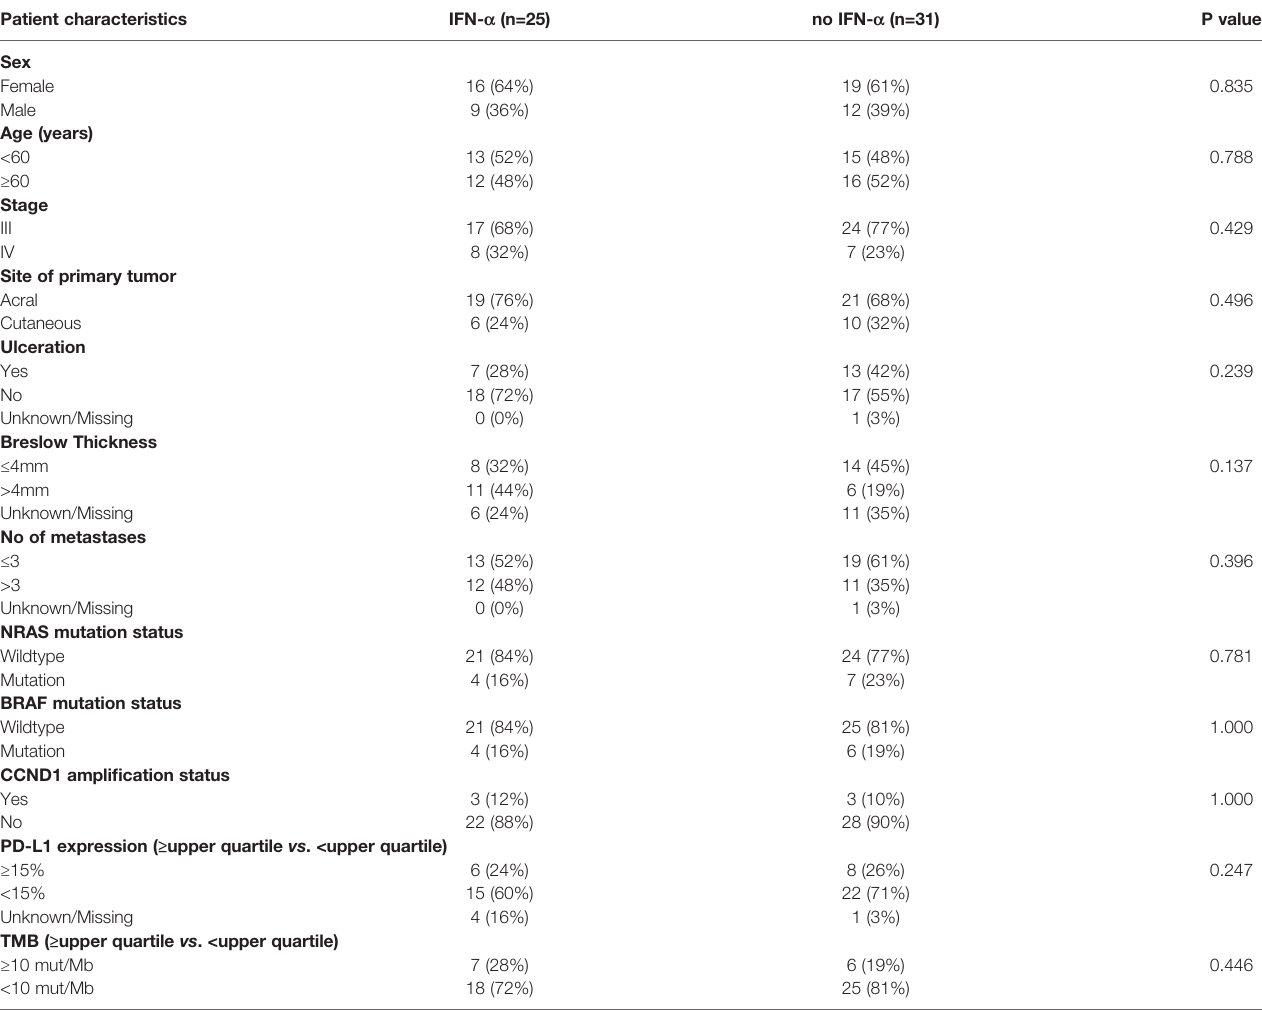
TABLE 1 | Demographic and clinical characteristics of